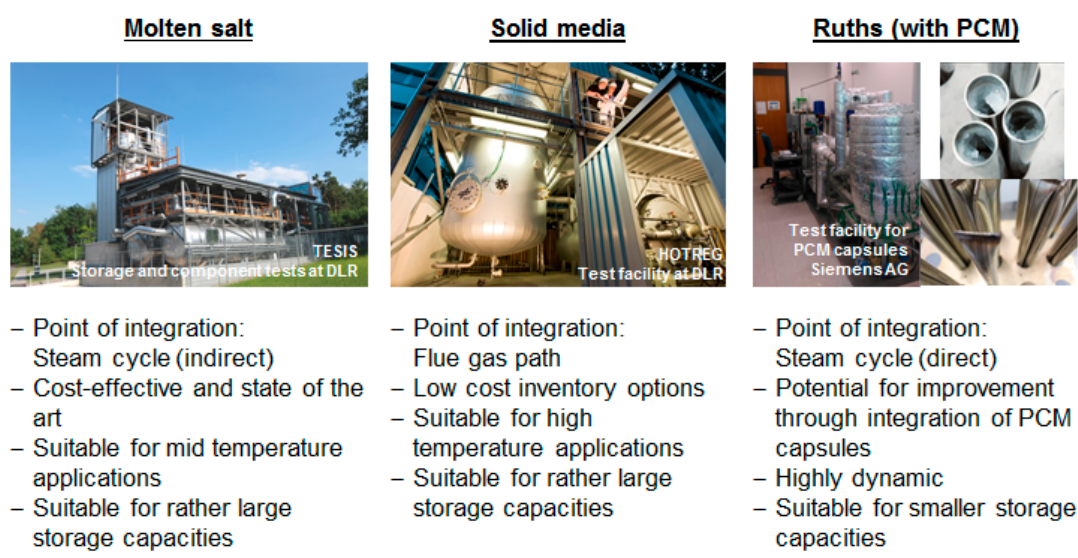
Figure 2. Thermal energy storage technologies considered in the FLEXI-TES project.